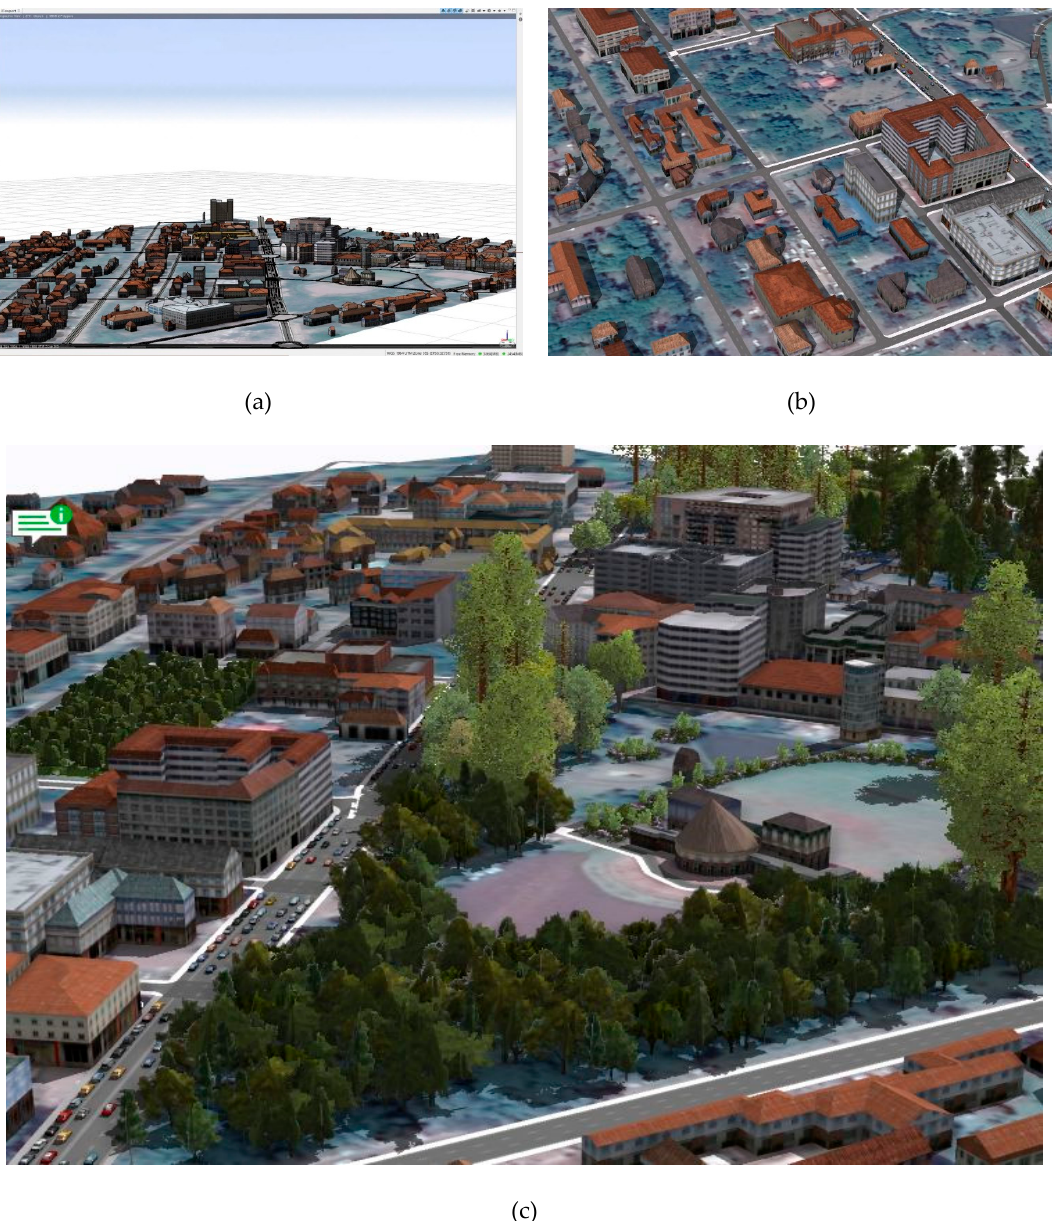
Figure 3. Captions of parts of the 3D city model of Kisumu. ( a ) Modelling environment before vegetative texturing, ( b ) Milimani area ( c ) Jomo Kenyatta Sports Ground.